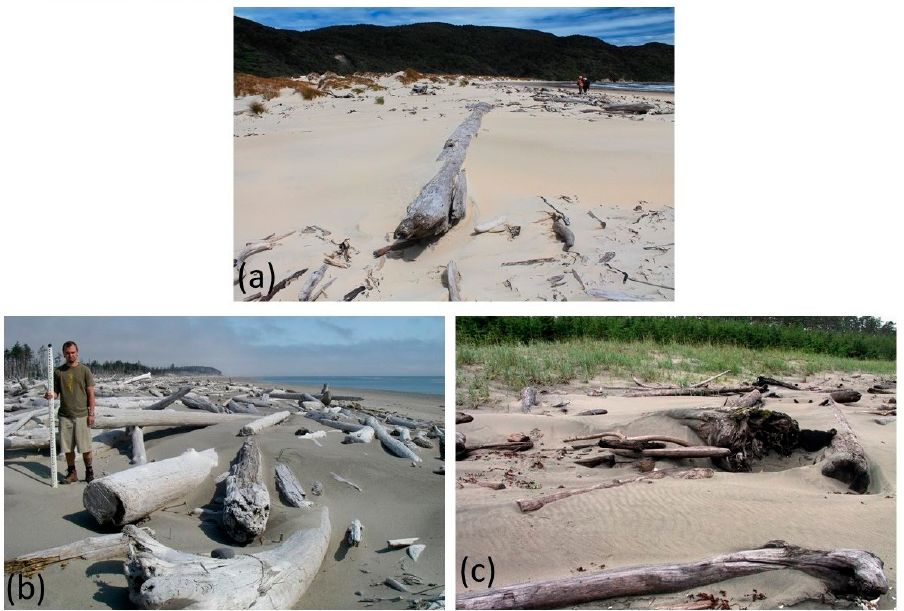
Figure 4. Photos of LWD deposits commonly found on beaches around the world. Photo ( a ) shows a partially buried log with up- and down-wind sand ramps: Stewart Island, New Zealand; ( b ) shows a dense matrix of logs with appreciable amounts of aeolian deposition common on open coasts in British Columbia, Canada; ( c ) shows a matrix of LWD with near complete aeolian infilling in front an established foredune that was scarped by as much as 1.5 m one year before the photo was taken. Photo credits: ( a ) B. Bauer; ( b ) and ( c ) I. Walker.